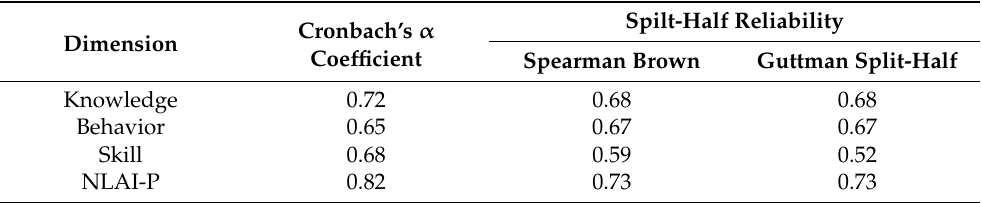
Table 7. Cronbach’s α coefficient and spilt-half reliability of NLAI-P.